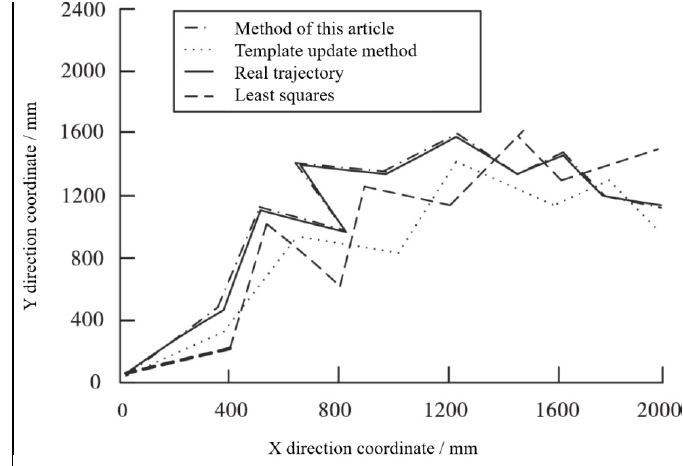
Fig. 6 Tracking error curve of arm coordinate position in different